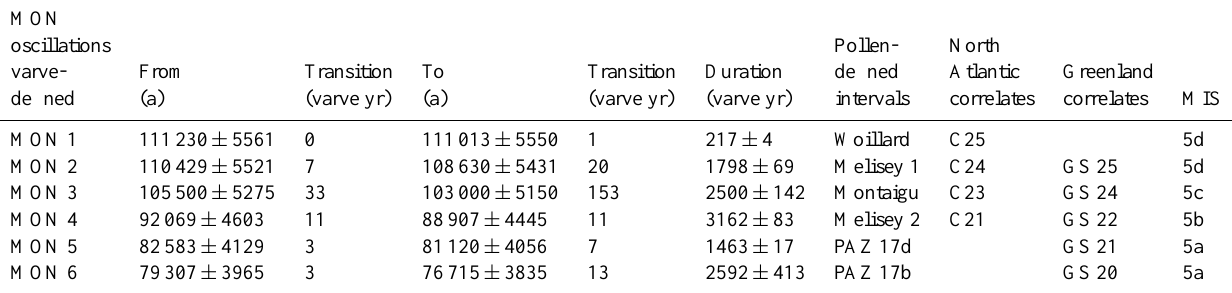
Table 1. Timing and duration of climatic oscillations MON 1–6 and their transitions (abruptness of varve thickness changes) onto the MON- 2014 timescale. Correlative events in terrestrial, marine and ice core stratigraphies across from Greenland to the Mediterranean are given for comparison. Uncertainty of absolute varve ages is given by the ± 5% accumulative counting error. Uncertainty on the duration of the MON oscillation is calculated from the differences between the MON-07 and the MON-2014 counts for those particular interval where the climate oscillation occur (Fig.